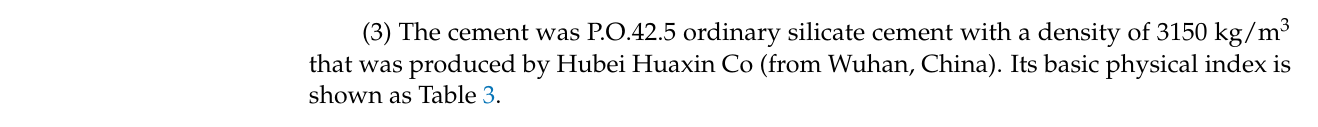
Table 3. Basic physical index of cement.